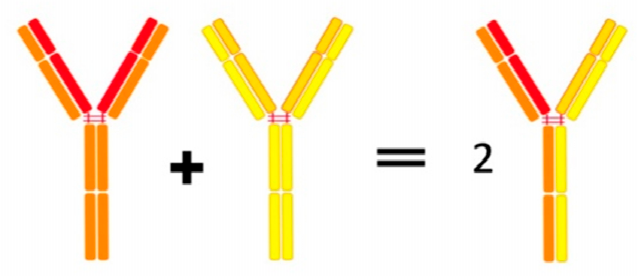
Figure 2. Configuration of IgG4 molecule after Fab exchange.